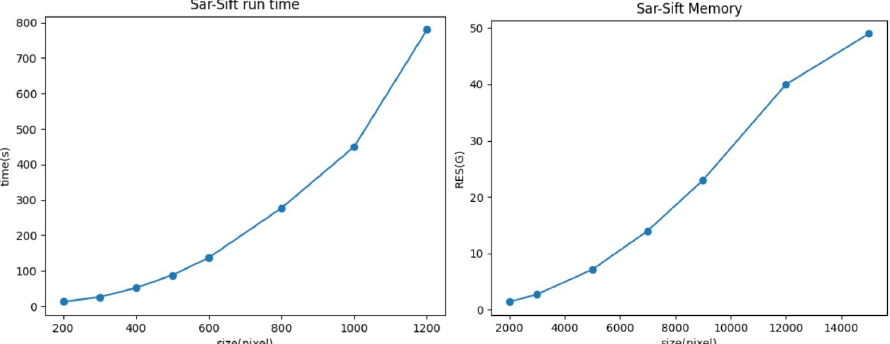
Figure 4. Trends in time and space consumption along with the image size, with SAR-SIFT as the 257 method. the method.